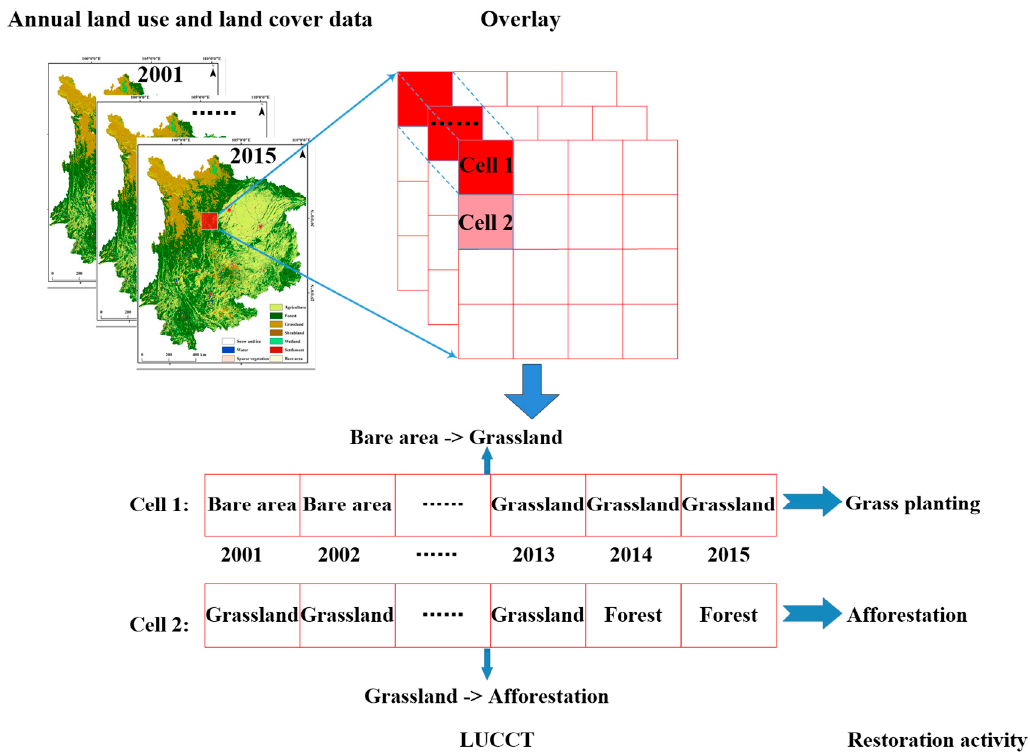
Figure 3. Grass planting and afforestation through LUCCT in